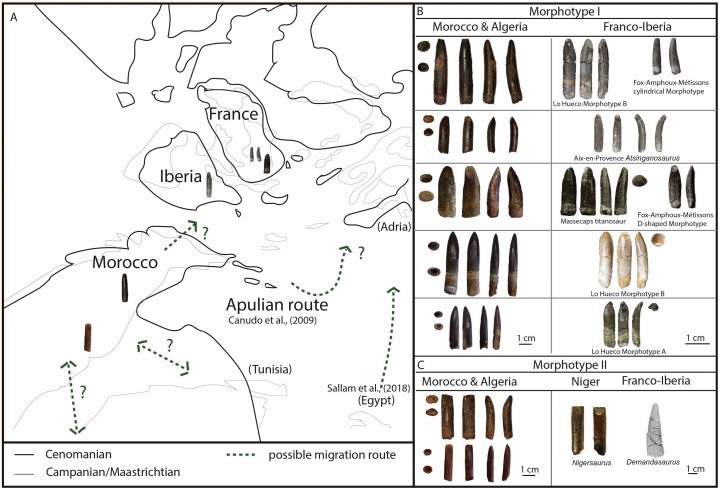
Palaeobiogeographical reconstruction of northwest Africa and southern Europe using sauropod tooth morphotypes.(A) northwest Africa and southern Europe during the Cenomanian (black line) and Campanian-Maastrichtian (grey line), with possible migration routes (dotted green line), adapted from Csiki-Sava et al., 2015. (B) Tooth morphotype I next to tooth morphotypes A and B from Lo Hueco (from Díaz, Ortega & Sanz, 2014) Fox-Amphoux-Métissons cylindrical type and D-shaped morphotype (from Díaz, Suberbiola & Sanz, 2012b), the Massecaps titanosaur and Atsinganosaurus (from Díaz, Tortosa & Loeuff, 2013). (C) Tooth morphotype II next to Nigersaurus from Sereno et al., 2007, and Demandasaurus (From Torcida Fernández-Baldor et al., 2011).